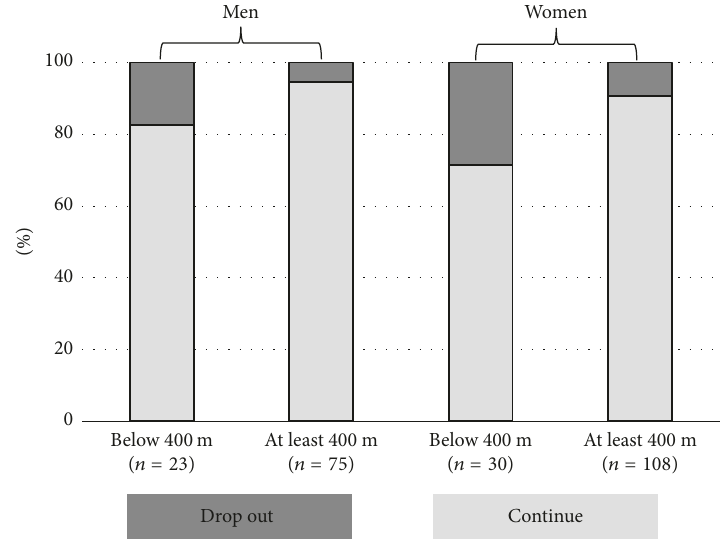
Figure 2: Associations between gait speed categories and risk of drop-out (chi-square statistics, 𝑃 = 0.065 for men and 0.008 for women; 𝑃 < 0.001 for men and women